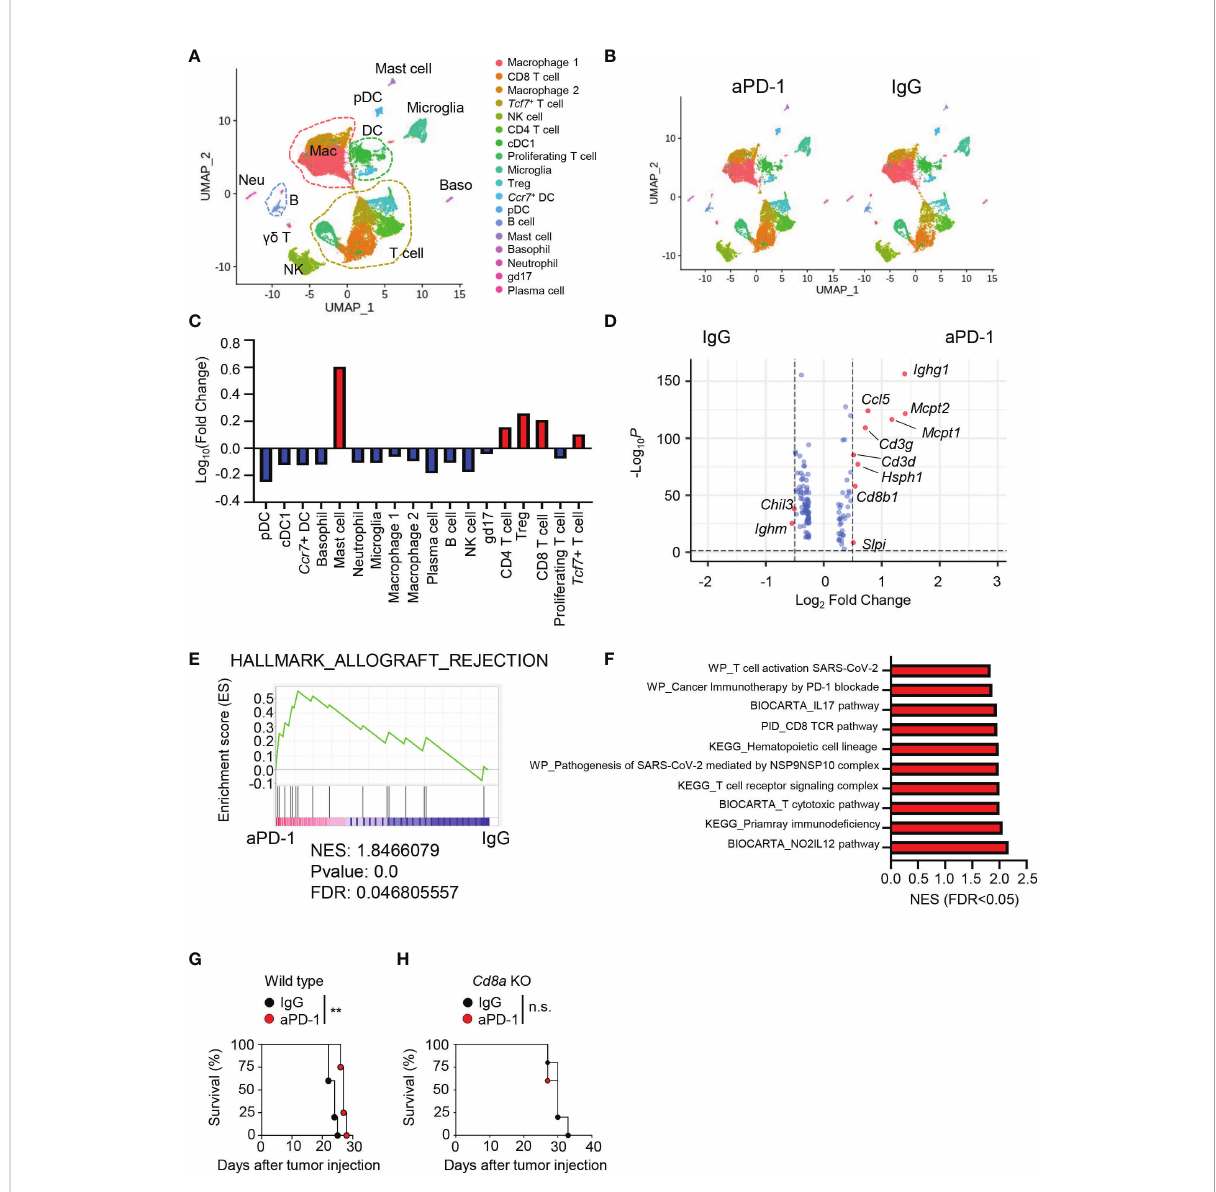
FIGURE 1 Immune landscape of brain tumor tissue after aPD-1 treatment. (A – F) Eight-week-old C57BL/6J mice were intracranially injected with GL261 cells and intraperitoneally injected with aPD-1 at 11, 13, and 15 days post tumor-cell injection. At day 20 after tumor-cell injection, tumor tissues were harvested and analyzed by scRNAseq. (A) Data were subjected to UMAP. (B) UMAP comparison between aPD-1 and IgG groups. (C) Log fold change of clusters after aPD-1 treatment compared with the IgG group was calculated. Red: increased; blue: decreased. (D) Volcano plot to visualize DEGs from whole cells of IgG-treated or aPD-1-treated groups. The cutoff fold change was 0.5, and the cutoff P value was 0.05. Red dots indicate signi fi cantly changed genes. Blue dots indicate non-signi fi cant genes. (E) DEGs were annotated to HALLMARK_ALLOGRAFT_REJECTION gene sets. (F) Gene sets from WikiPathways (WP), BIOCARTA, the Pathway Interaction Database, and KEGG were used to fi nd signi fi cantly upregulated pathways. (G, H) Wild type (WT) (G) or Cd8a -knockout (H) mice were intracranially injected with GL261 cells. aPD-1 antibody was injected intraperitoneally at 11, 13, and 15 days post tumor-cell injection. Survival was monitored. Survival data were analyzed by log-rank test. * P <0.05, ** P <0.01. NES, normalized enrichment score; FDR: false discovery rate. n.s., not signi fi